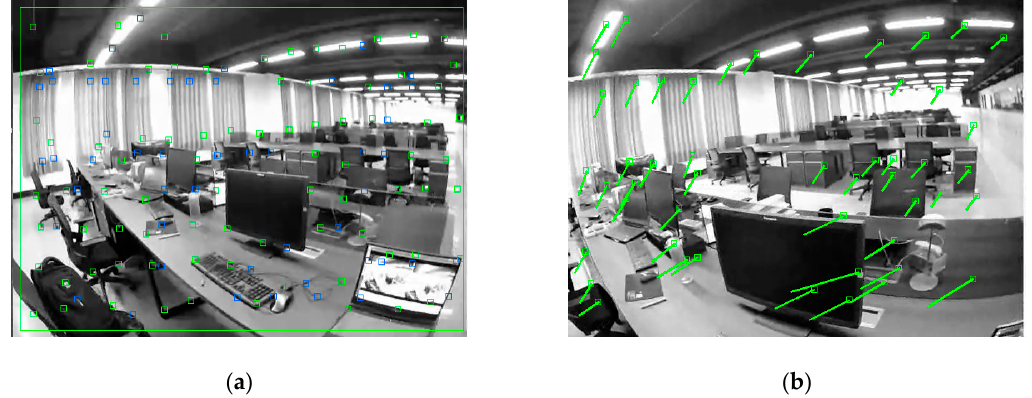
Figure 4. ( a ) FAST corner points distribution managed by the gridded map strategy; ( b ) Feature points tracked by the optical flow method.